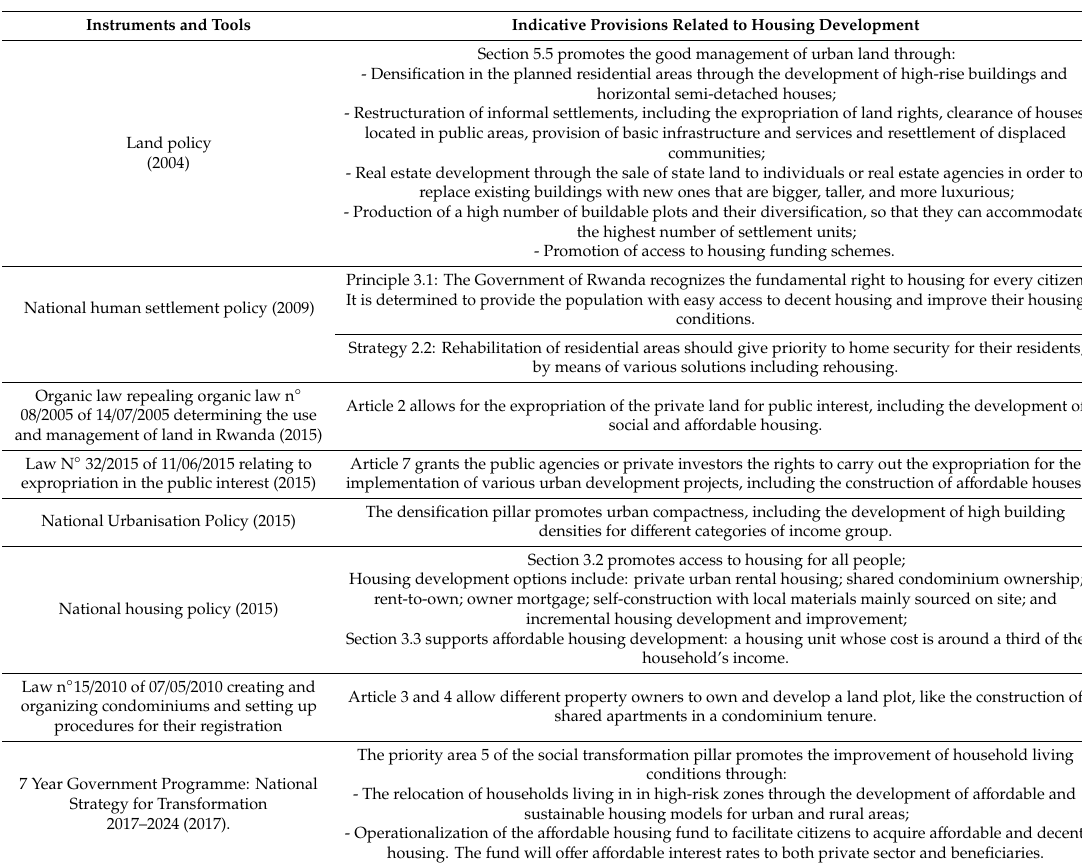
Overview of regulations related to housing development in